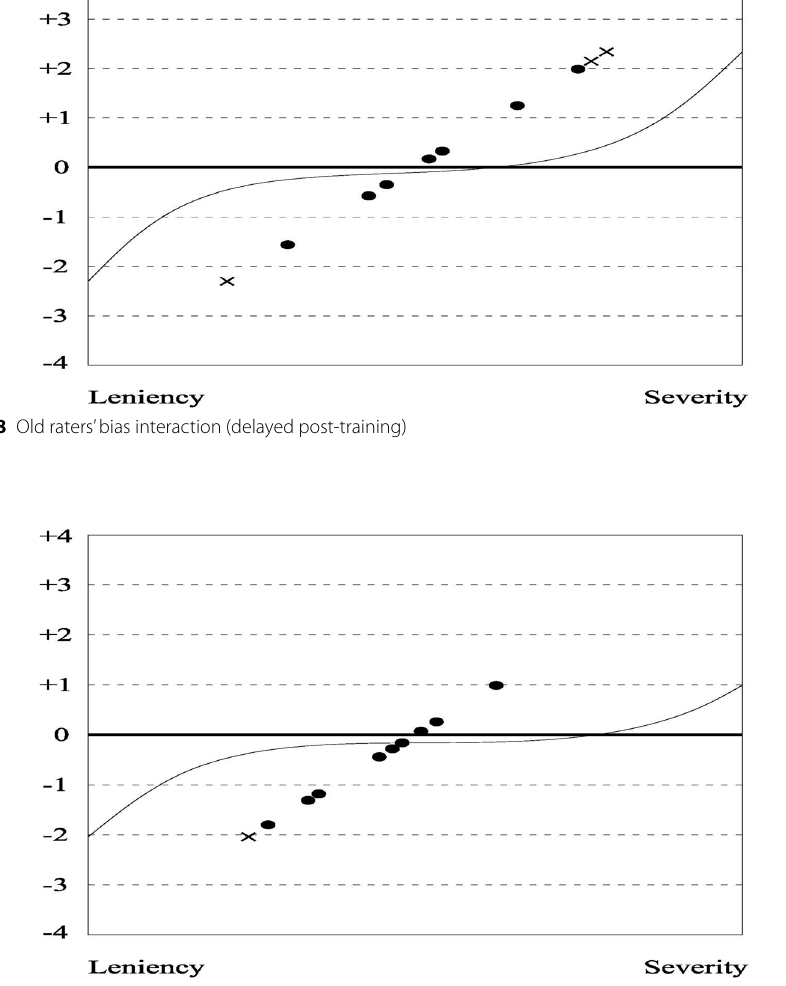
Fig. 9 New raters’ bias interaction (delayed